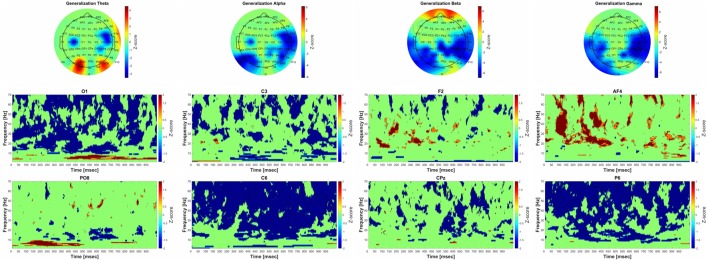
Significant group-level changes in the power of the different frequency bands during generalization. The power of the investigated four frequency bands (theta, alpha, beta, gamma) during generalization were compared to the baseline activity using nonparametric permutation test with correction for multiple comparisons at the minimum-maximum point of the null-hypothesis distribution. The upper part of the figure shows the FFT results of the 64 channel EEG recordings in topographic representation in different frequency band during generalization, while the lower part of the figure corresponds to the group-level time-frequency results in different channels (O1, C3, F2, AF4, PO8 C6, CPz, P6, respectively). The color scales beside the upper three panels indicate the z-score values, obtained by calculating cluster-mass statistics in individual power changes between generalization and baseline activity. The red color indicates significant power-increase and the blue color represents significant power-decrease compared to baseline. The z-scores threshold was set to 1.645 (which is equal to the 0.05 p-value).